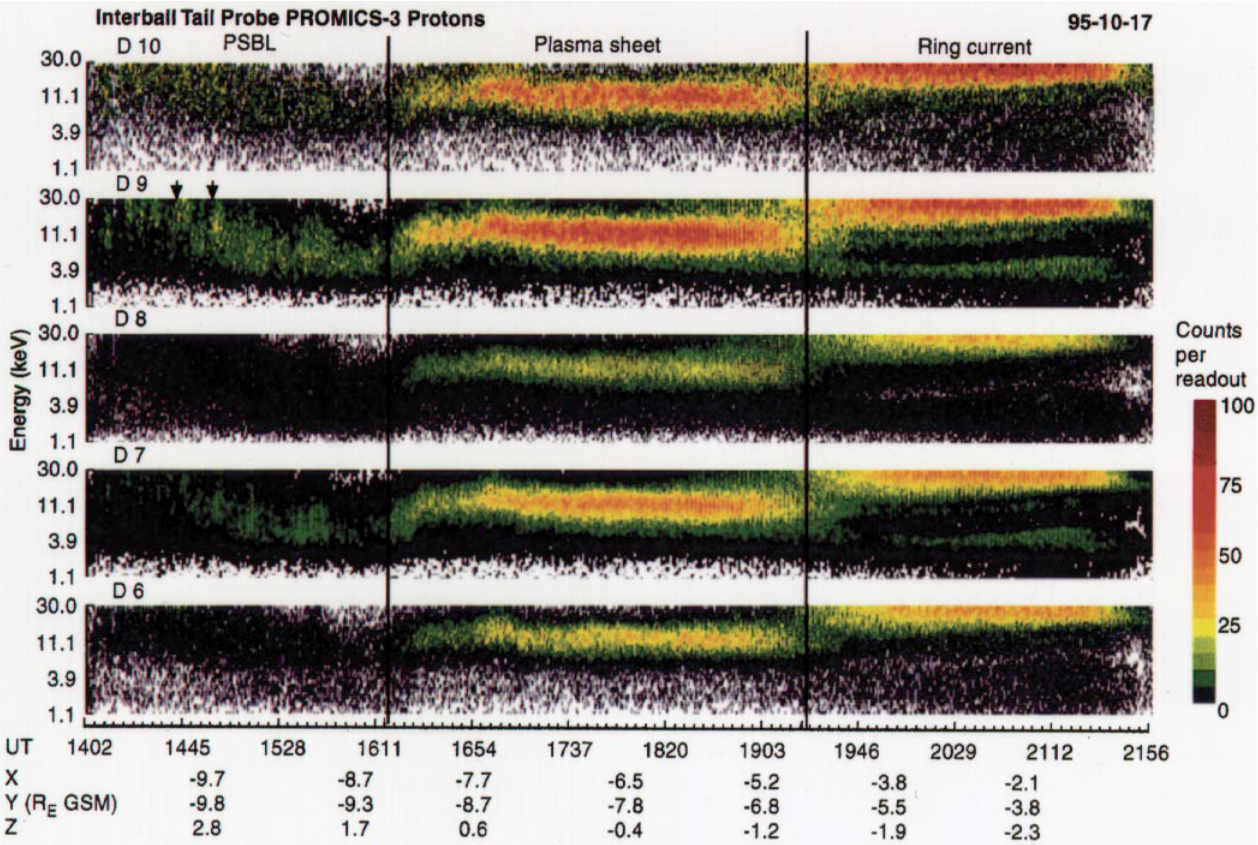
time for detectors D7 and D9 is twice as long as for D6, D8, and D10. „ wo arrows above the second panel mark field-aligned